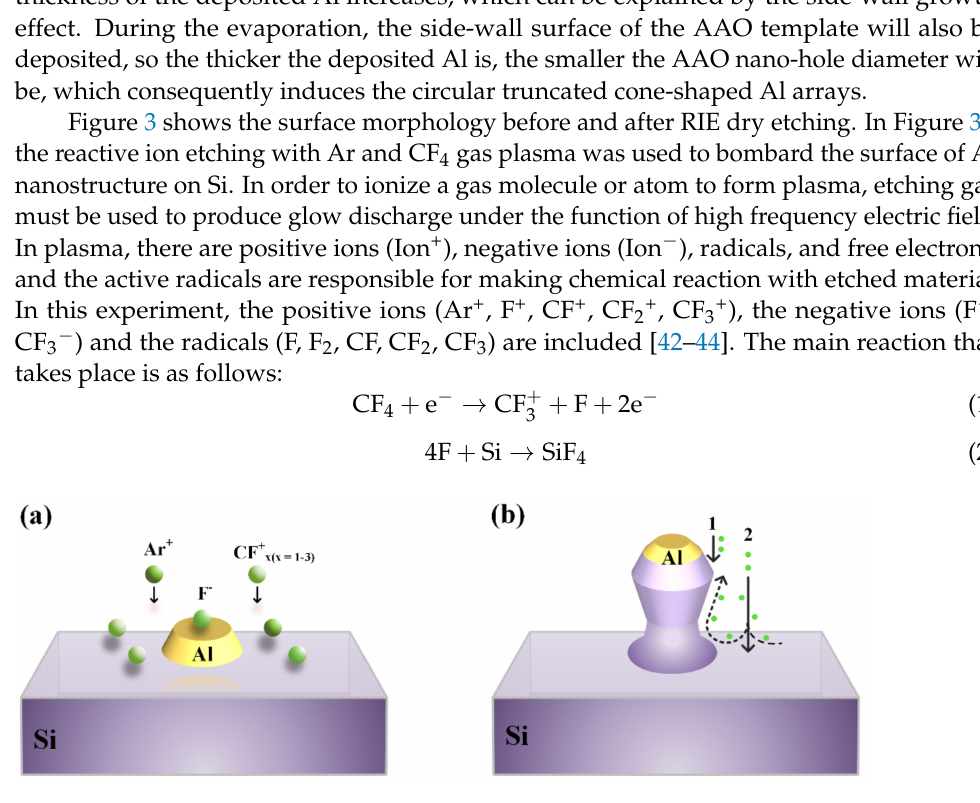
Figure 3. Schematic diagram for the formation of the cup-shaped Si nano-pillar arrays. ( a ) Al cylinder on the Si substrate at the beginning of RIE dry etching, ( b ) RIE dry etching mechanism for cup-shaped Si nano-pillar structures (1: the formation of the mouth of the cup, 2: the formation of the body of the